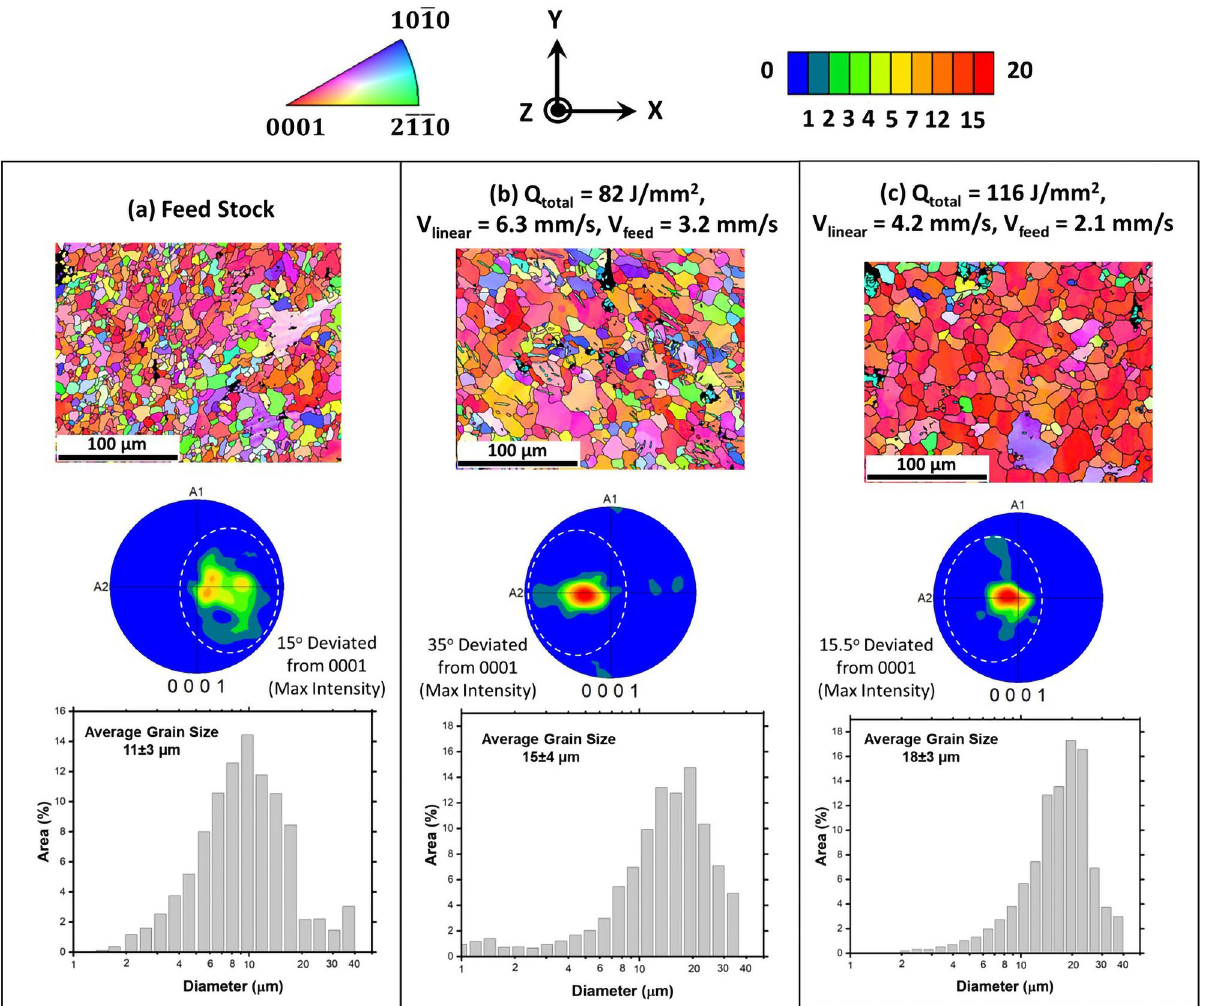
Figure 3. EBSD data showing OIM, texture plots, and grain size distributions corresponding to ( a ) feed stock, 2 2 ( b ) 82 J/mm , and ( c ) 116 J/mm